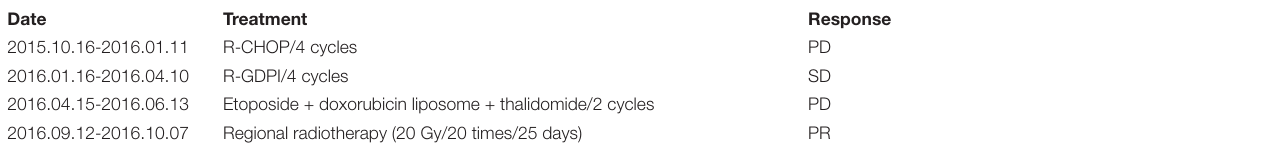
TABLE 1 | Treatment process and results.